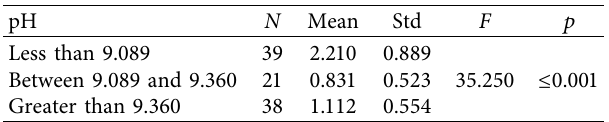
Table 5: Results of the analysis of variance in ovomucin con- centration at various pH